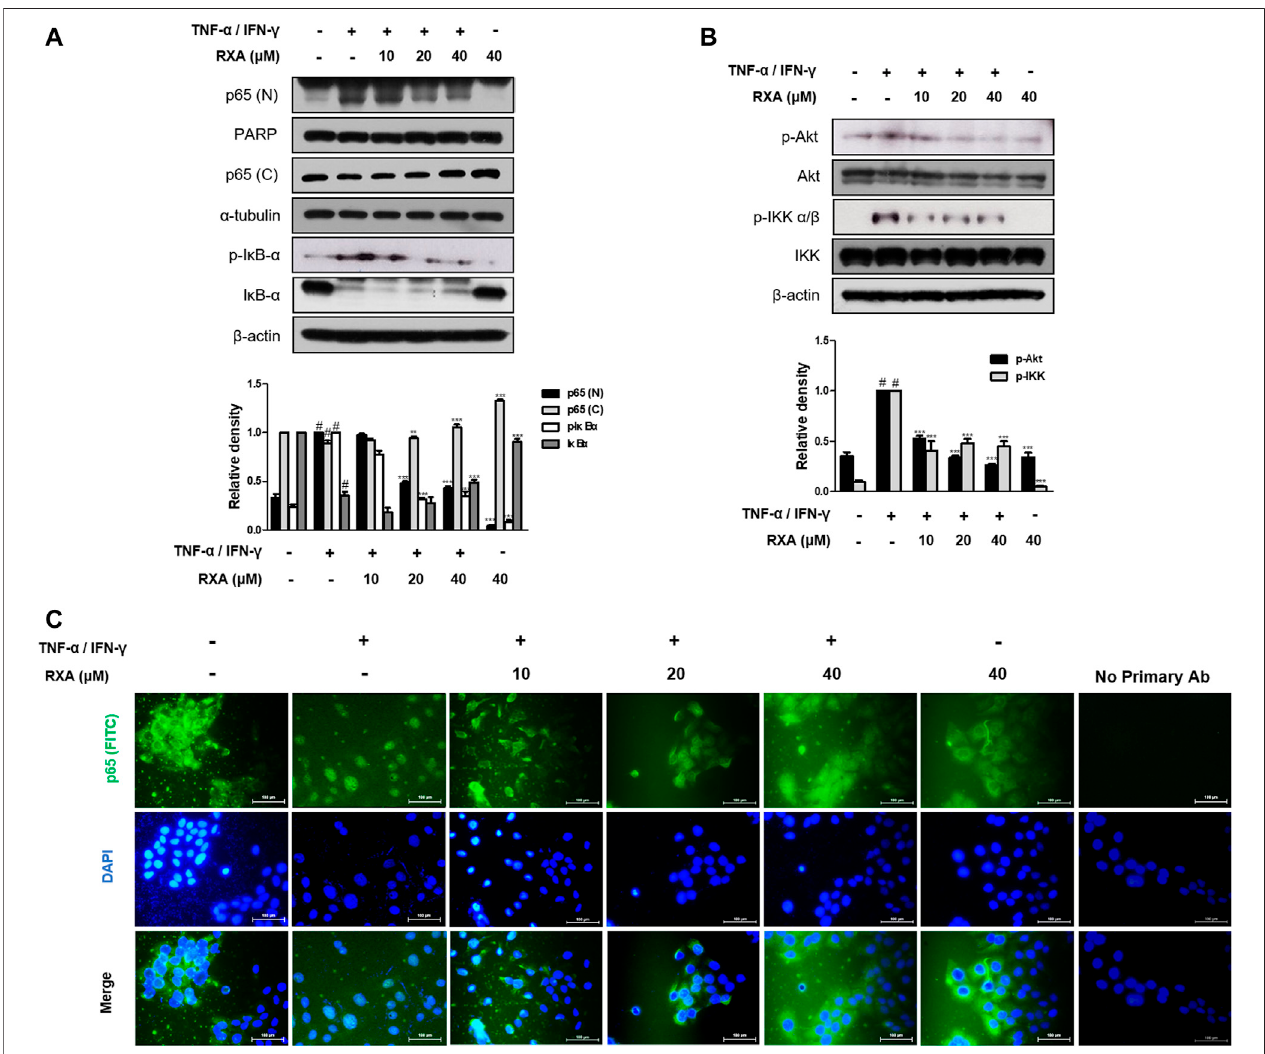
FIGURE 6 | Effects of RXA on the NF- κ B activation in TNF- α /IFN- γ -stimulated HaCaT keratinocytes. (A) Cells were pre-treated with RXA and then stimulated with TNF- α /IFN- γ . Nuclear (N) and cytosol (C) extracts were isolated, and levels of p65 in fractions were determined by Western blotting. Total proteins were prepared and WesternblottedforI κ B- α , (B) Akt,andIKK. β -actin,PARP,and α -tubulinwereusedasinternalcontrols. (C) Immuno fl uorescencestainingofNF- κ B(green)inTNF- α /IFN- γ -stimulated HaCaT keratinocytes. Nuclei were counterstained using DAPI (scale bar (cid:1) 100 μ m). Secondary antibody only control was used as negative control. The data shown represent mean ± S.D. of three independent experiments. # p < 0.05 vs. the control group; ** p < 0.01, *** p < 0.001 vs. TNF- α /IFN- γ -stimulated group.